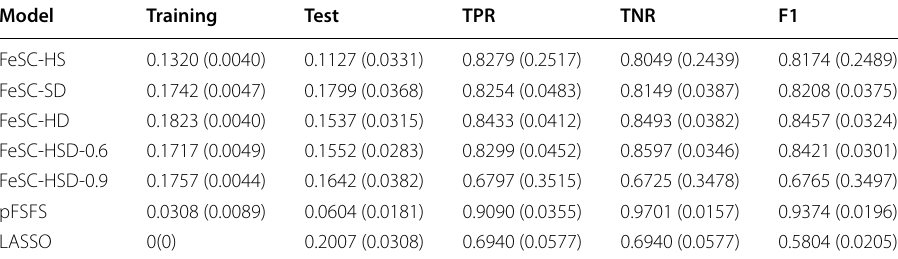
Table 3 Training and test MCE in the LH dataset across 10 runs. Results are expressed in terms of average (standard